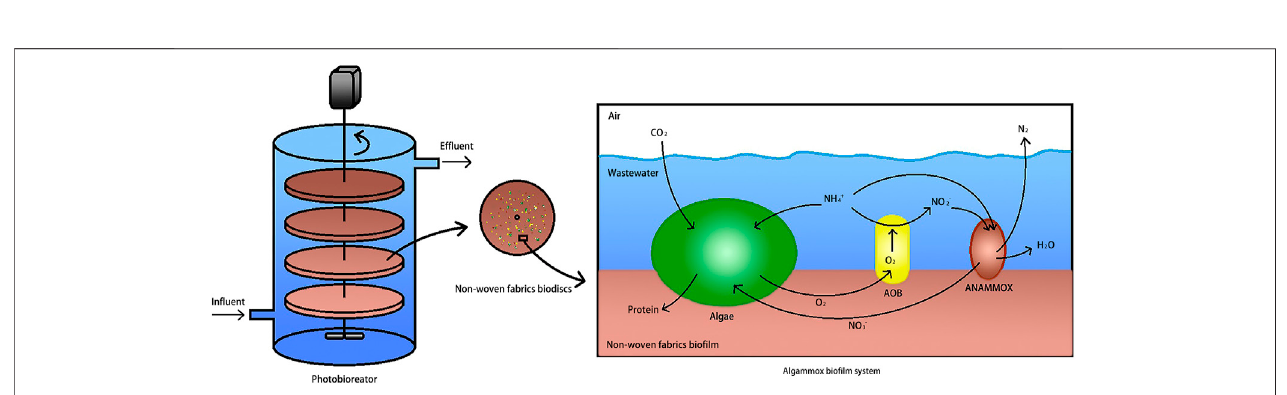
FIGURE 9 | Operation of algammox bio fi lm system in the photosequencing batch reactor.